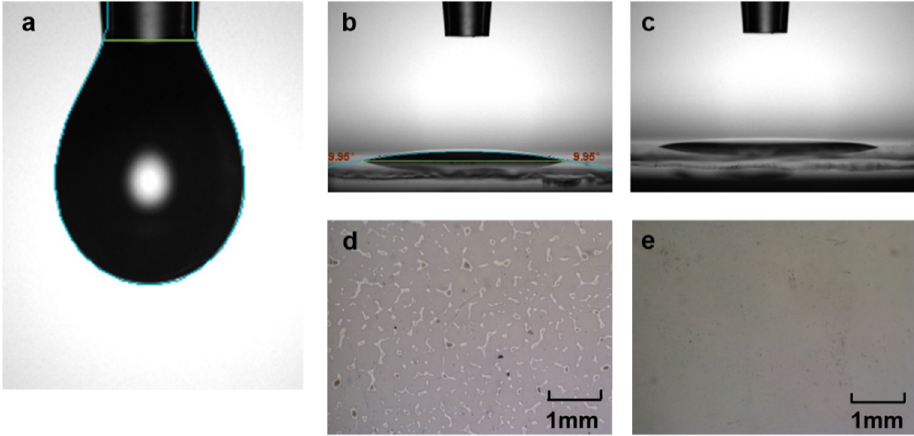
Figure 1. ( a ) The surface tension of In x Zr y O precursor solution. ( b ) Contact angle of precursor solution on the glass substrate without UV treatment. ( c ) Contact angle of precursor solution on the glass substrate with UV treatment. ( d ) Top view of In x Zr y O film on glass substrate without UV treatment. ( e ) Top view of In x Zr y O film on glass substrate with UV treatment.